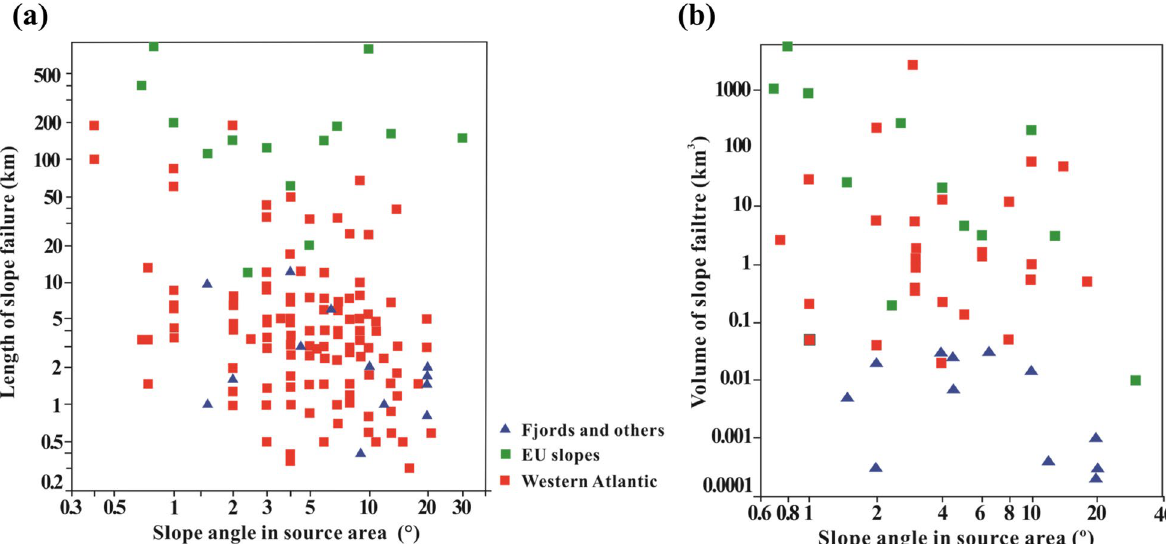
Fig. 19 Logarithmic scatter plot of slope instability parameters at different slope angles (modified from Hühnerbach and Masson